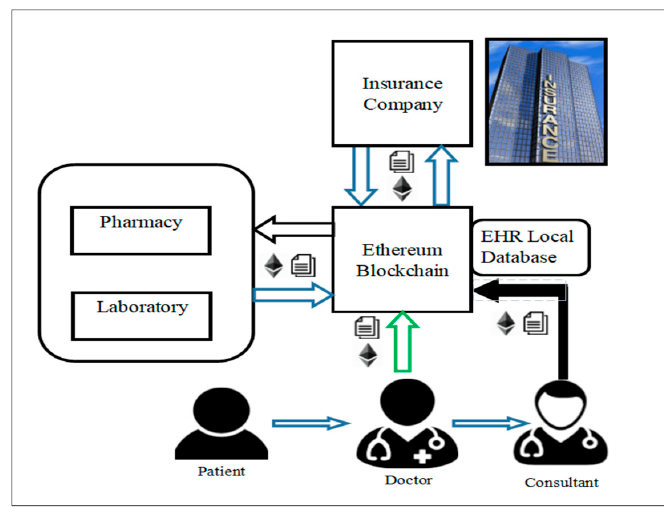
Figure 6. Smart contracts for healthcare reimbursement.